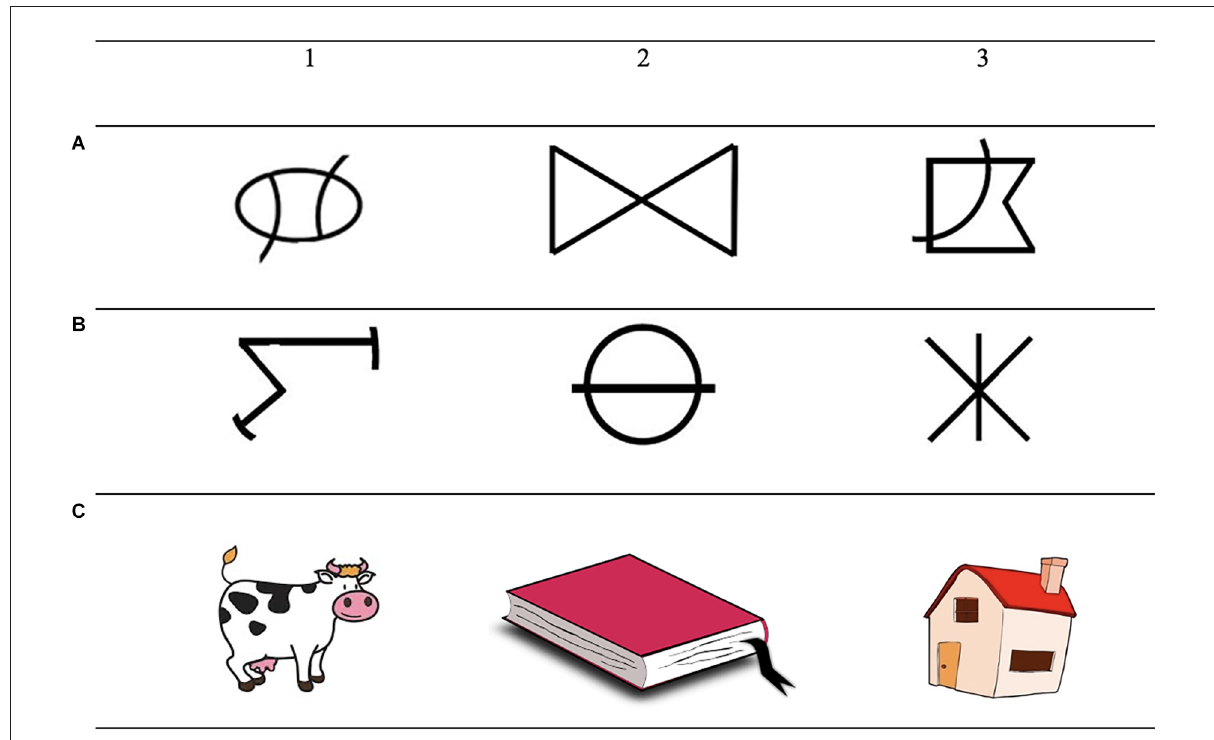
FIGURE1 The figures show the stimuli that were used in the equivalence experiments. Note: The letters (A–C) vertically on the left side indicate the members of the class and the numbers (1–3) above the images indicate to which class the stimuli belong.